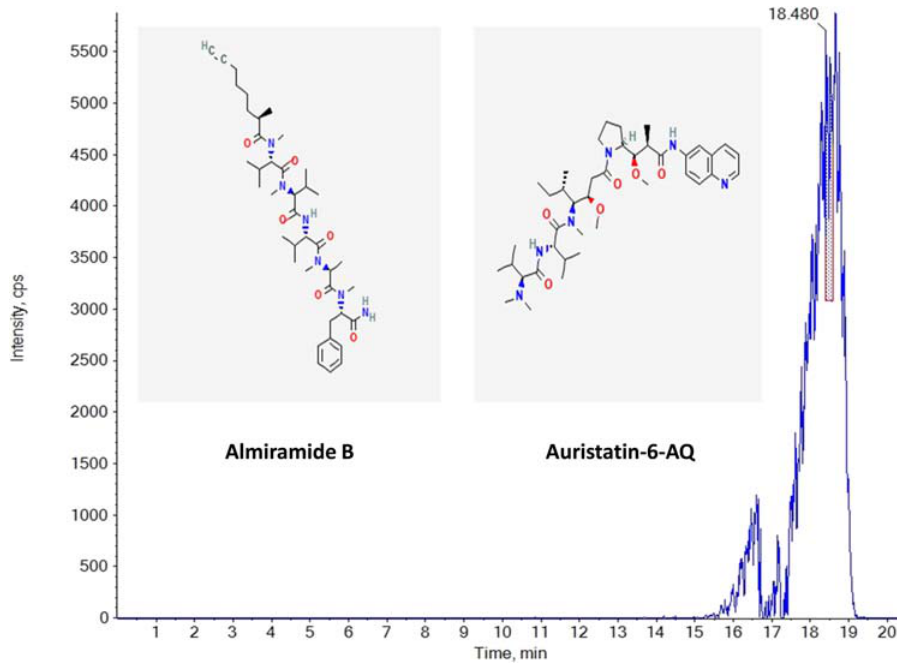
Figure 5: The short peptide of the Z. spina - christi honey. The short peptide was de fi ned as Auristatin - 6 - AQ or Almiramide B [ 29 – 31 ]